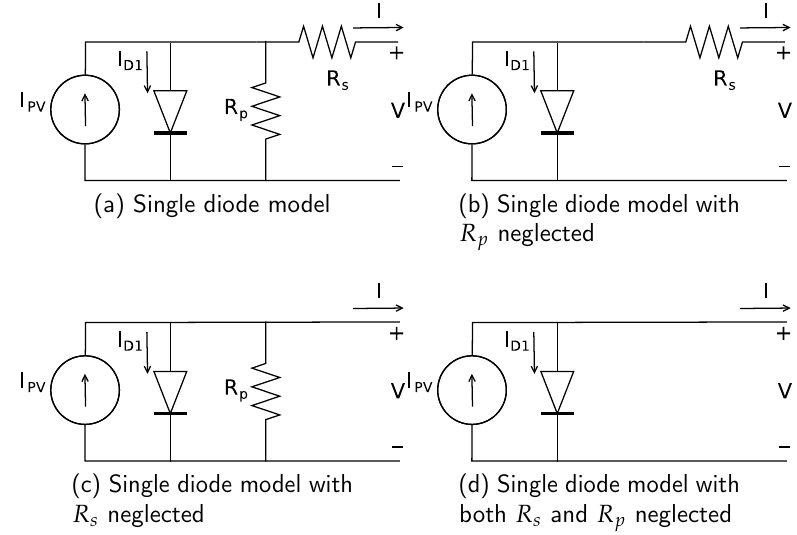
Figure 2. PV array models with decreasing